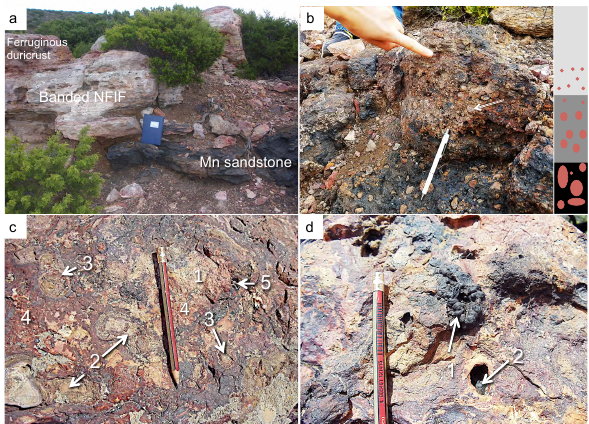
Figure 8. Field sedimentology and stratigraphy of Section B se- quence, host to the NFIF. (a) Sharp boundary between lower Mn sandstone and unconformably overlying NFIF capped by a ferrugi- nous duricrust. (b) Sandstone–sandy tuff pebble to gravel conglom- erate facies, showing an upward fining character, locally overlies the Mn sandstone bed and is capped by sharp erosional contact with the overlying NFIF. The tip of the pen (7cm long) rests on a late blue–black Mn oxide overprint. (c) Ferruginous duricrust made up of lithic fragments composed of (1) Fe nodules (2) and Fe concre- tions (3) in a hematite-rich matrix (4). (d) Matrix dissolution result- ing in vermiform Mn nodules (1) and cavity black Mn oxide (2) infillings, post-dating the ferruginous duricrust